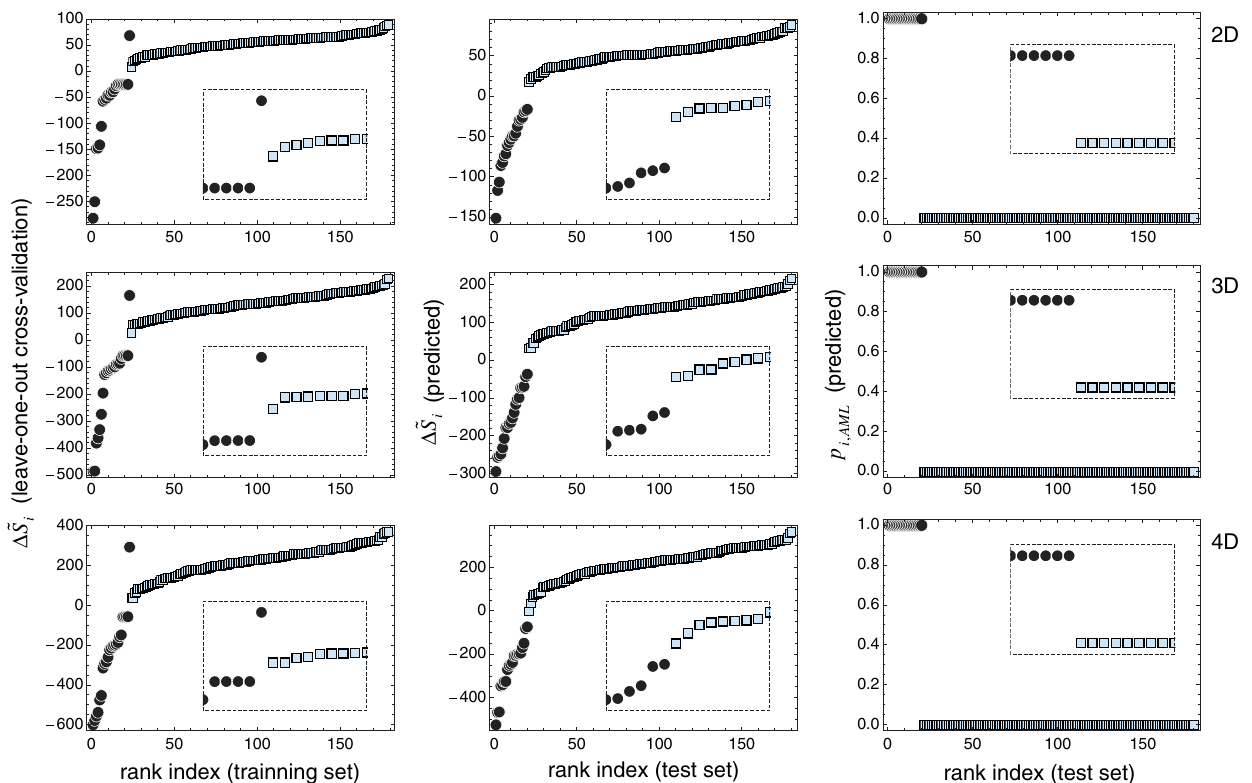
FIG. 4. Weighted-entropy enhancement of the discrimination between AML and normal individuals. Same situation as in Fig. 2 but ~ S with the weights w k that maximize the distance ΔΔ of the training set excluding patient no.